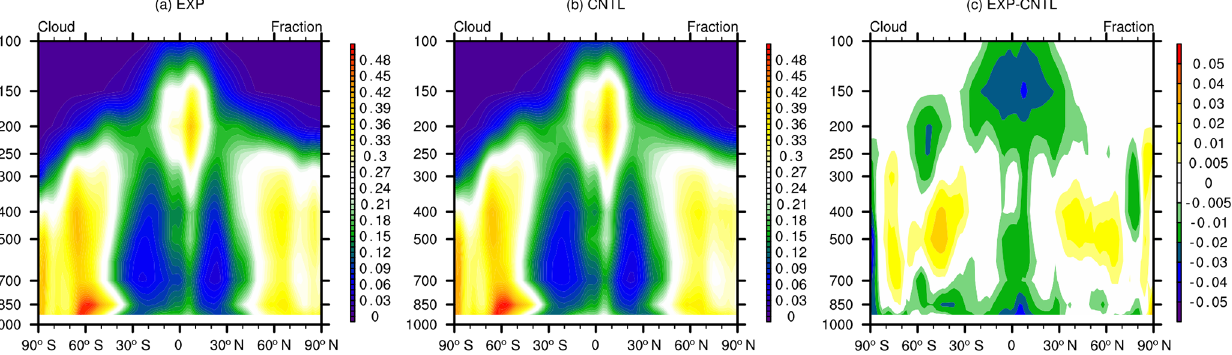
Figure 10. Pressure–latitude distributions of cloud fraction of EXP (a) , CNTL (b) , and EXP–CNTL (c) .